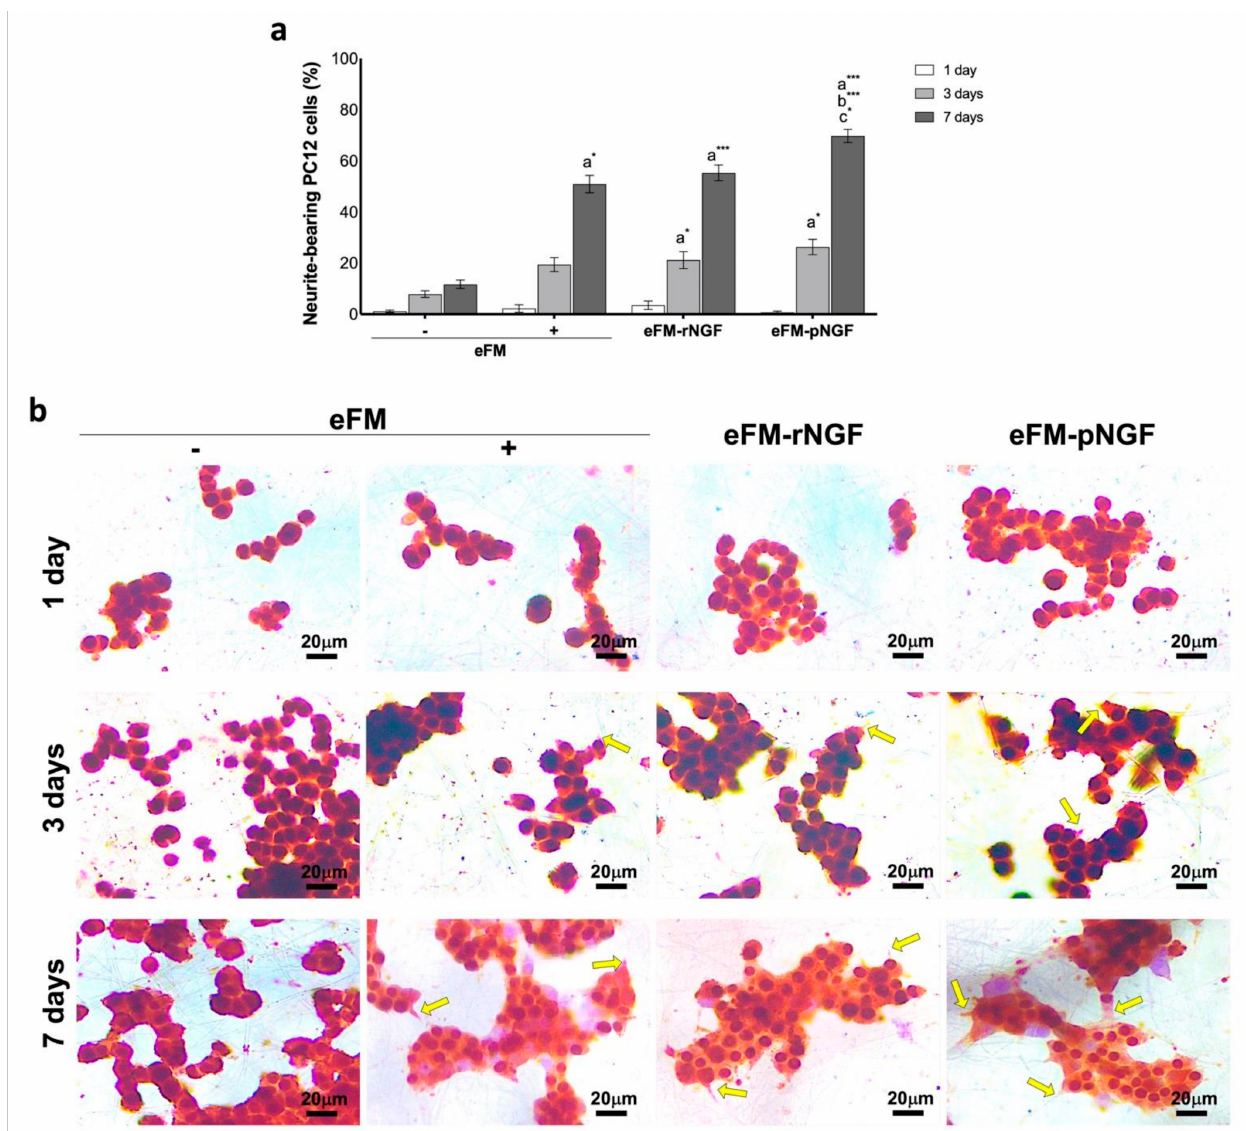
Figure 3. Neurite-bearing PC12 cells. (Top) Percentage of neurite-bearing PC12 cells on the different culture conditions along culturing time ( a ). The one-way ANOVA with the Tukey’s HSD post hoc test were applied ( p < 0.01): a represents significant differences compared to eFM − ; b represents significant differences compared to eFM+, and c represents significant differences compared to eFM- rNGF; * p < 0.01; *** p < 0.0001; (Bottom) Immunocytochemistry with beta-III Tubulin (brown) of PC12 cells on different culture condition along culturing time ( b